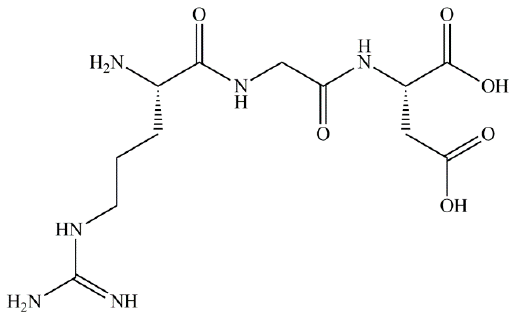
Figure 1. Chemical structure of the Arg-Gly-Asp (RGD) tripeptide sequence. Some human pathogenic bacteria, fungi and viruses use integrins to attach to target cells. Staphylococcus aureus Clumping Factor A binds fibrinogen and the von Willebrand factor, and the major cell wall protein PspC of Streptococcus pneumoniae binds vitronectin to crosslink the bacteria to the integrin α v β 3 [14,15]. The outer membrane protein A of Escherichia coli contains the RGD motif and binds directly to α v β 3. Several viruses appear to utilize their expression of the RGD motif to facilitate their attachment to or entry into host cells via interactions with the host cell’s integrins. Clinically important RGD-containing viruses include the human metapneumovirus, human adenovirus subtype 5, human cytomegalovirus and the Epstein–Barr virus [16]. A recent actuality of the RGD motif in the COVID-19 pandemic is that after Wei et al. determined the ACE2 receptor-binding domain of the SARS-CoV-2 spike protein (S-protein) in 2020 [17], Sigrist and colleagues highlighted the presence of the RGD sequence on the surface of the protein not far from the ACE2 binding region and suggested its potential role in the entry into the host cell [18].